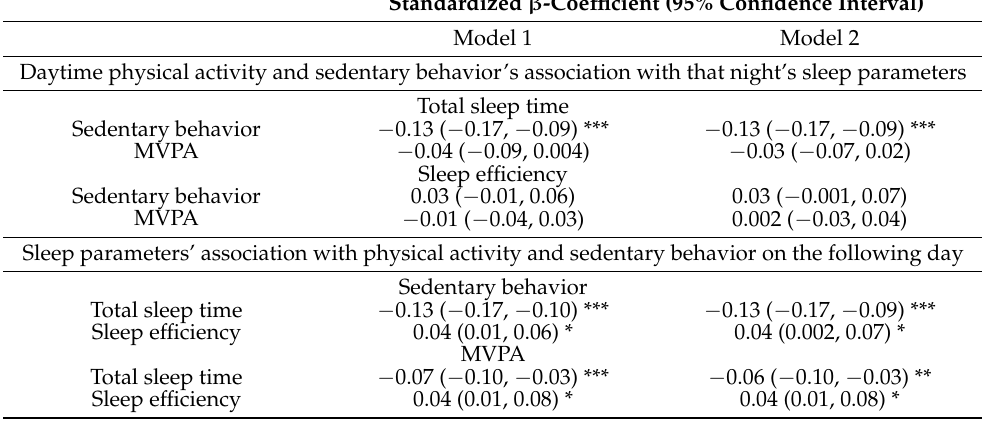
Table 3. Multilevel linear mixed models showing the bi-directional, day-to-day associations between physical activity behaviors (MVPA and sedentary) during the day and that night’s sleep parameters (total sleep time and sleep efficiency), and sleep parameters’ associations with physical activity behaviors during the following day ( n = 324).